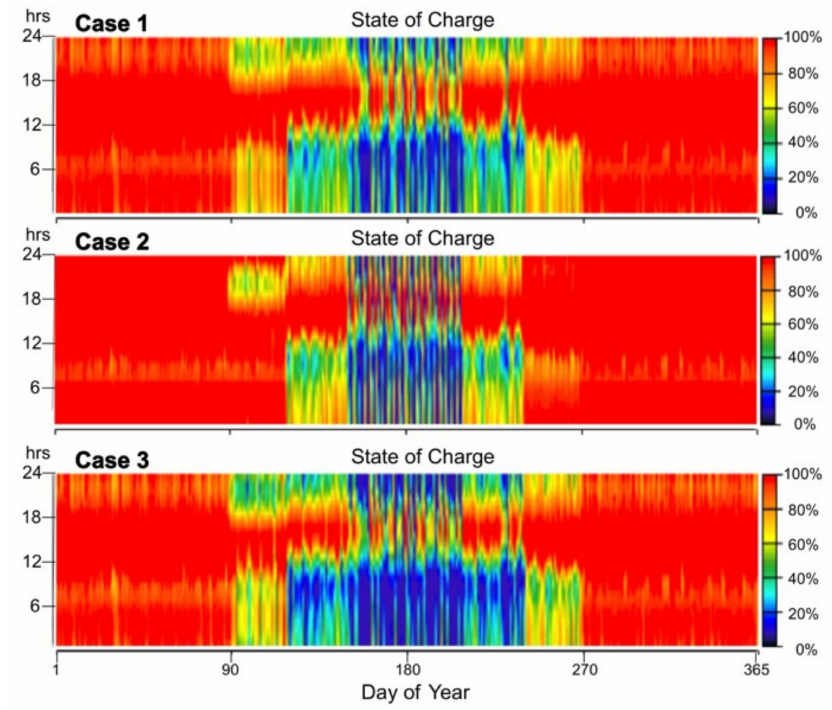
Figure 14. Annual profiles for SOC for HOMER-optimized cases 1, 2, and